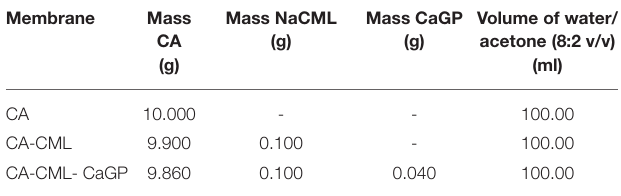
TABLE 1 | Formulation used for the preparation of the membranes.